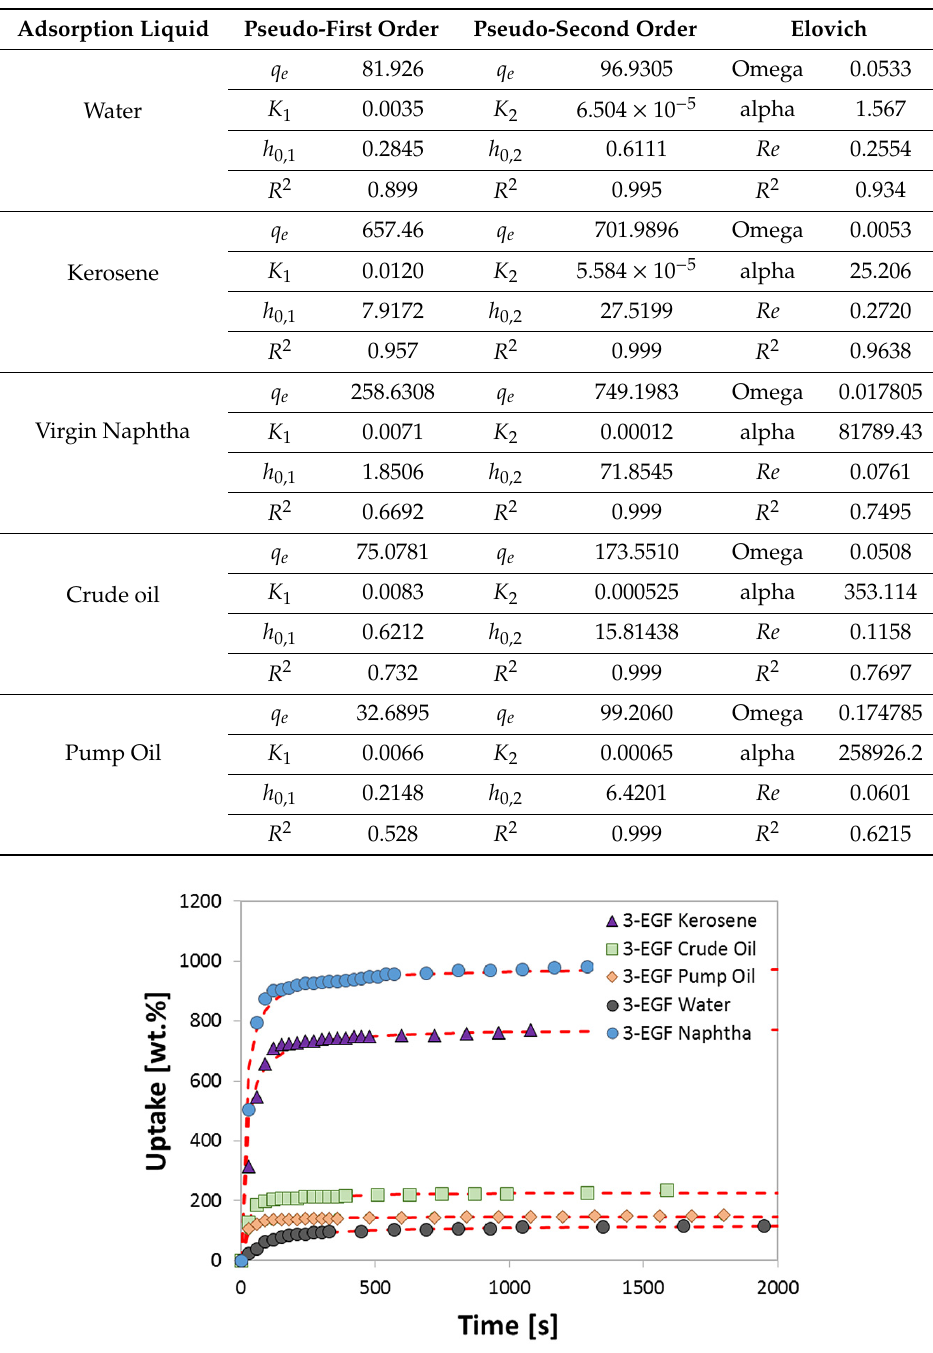
Table 9. The kinetic coe ffi cients of the PFO, PSO and Elovich models for 7-EGF foam.